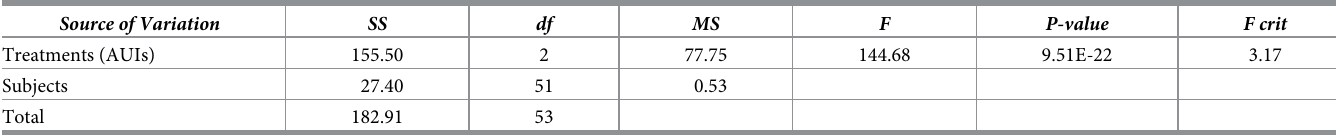
Table 22. One-way ANOVA—Viewpoint #7.